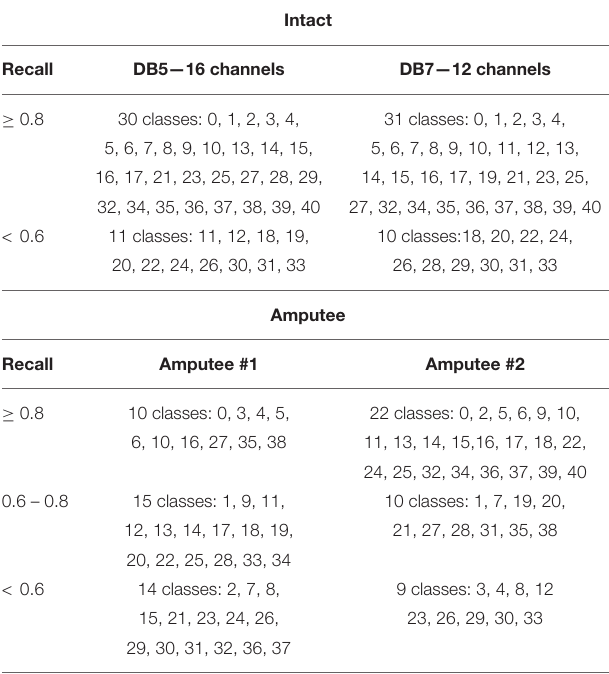
TABLE 2 | Hand movement classes from DB5 and DB7 intact participants, and from DB7 amputees #1 and #2, grouped by